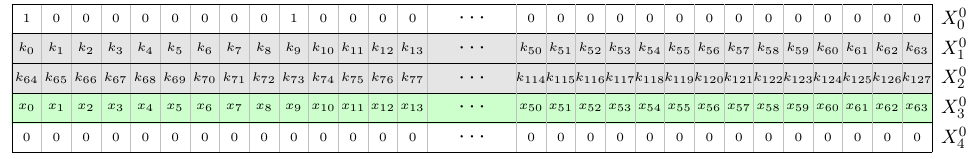
Figure 9: Initial state with cube variables in X 0